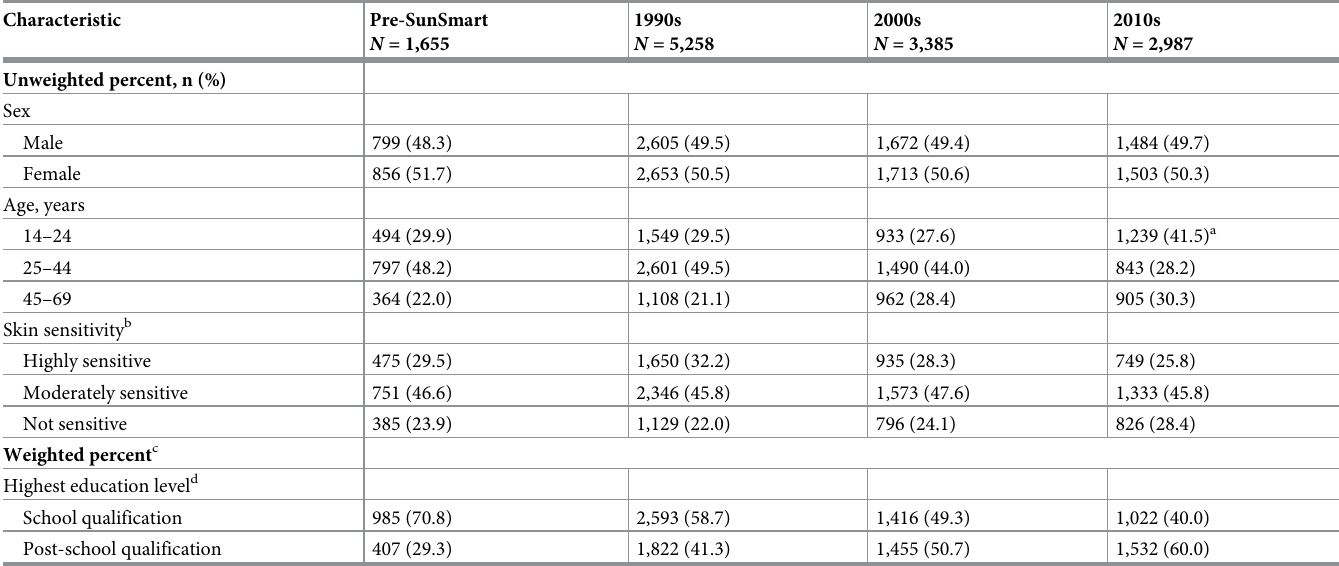
Table 1. Demographic characteristics of respondents by